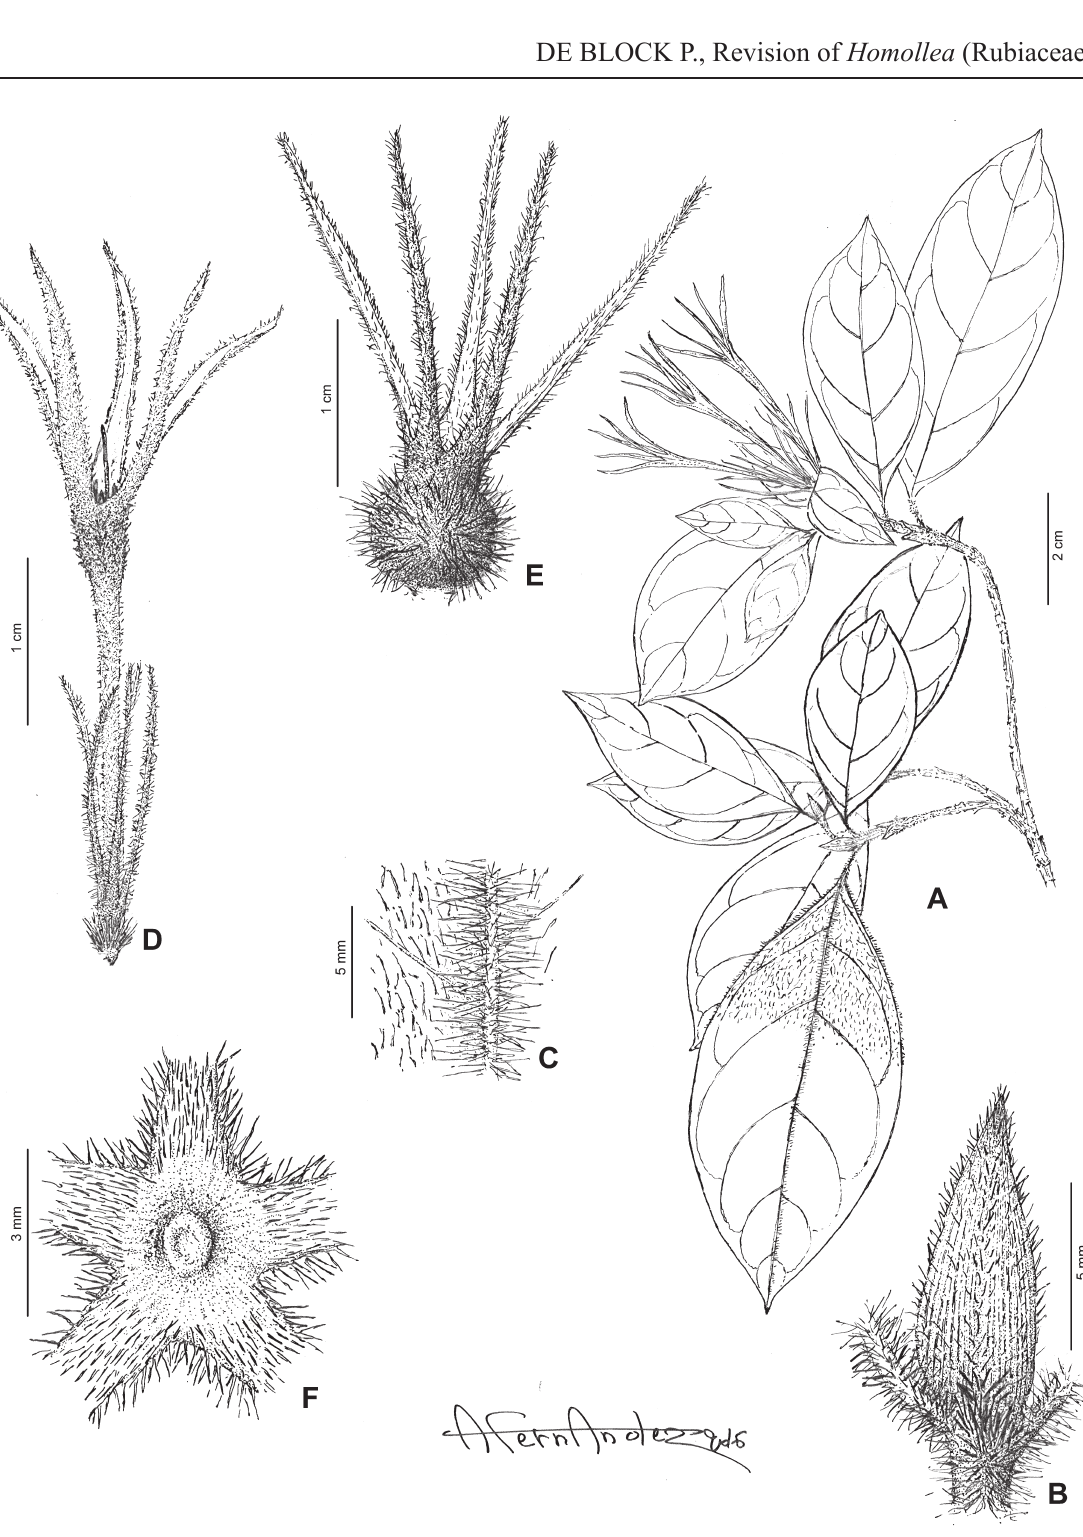
Fig. 5. Homollea septentrionalis De Block sp. nov. A . Flowering branch. B . Stipule. C . Detail of lower surface of leaf, showing pubescence on midrib and blade. D . Flower. E . Fruit. F . Apical view of disc and pubescent adaxial surface of calyx tube and lobes (base only). Drawn by Mr. A. Fernandez. A–D from Nusbaumer & Ranirison 1468 (BR); E–F from Ranirison & Nusbaumer 961